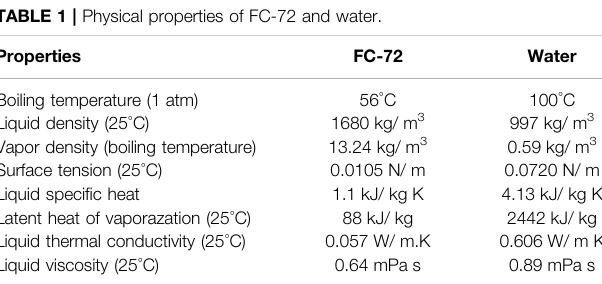
TABLE 1 | Physical properties of FC-72 and